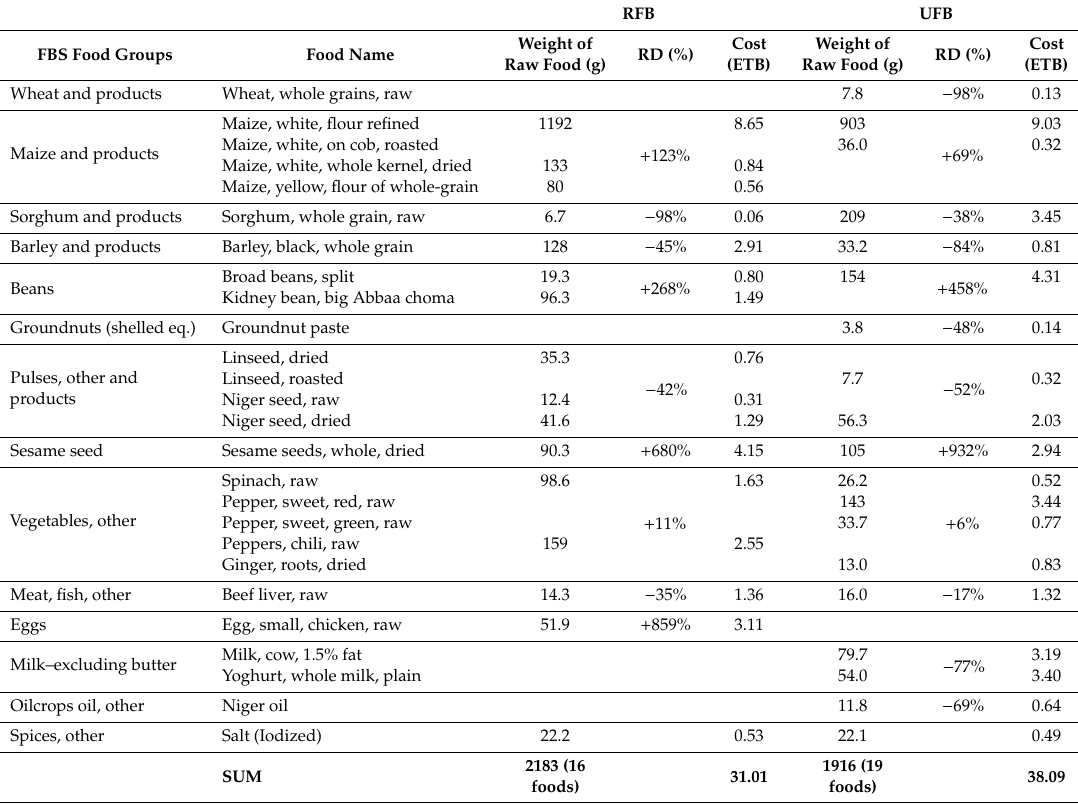
Table 3. Nutritionally adequate rural and urban food baskets for an Ethiopian family of five optimized for cost